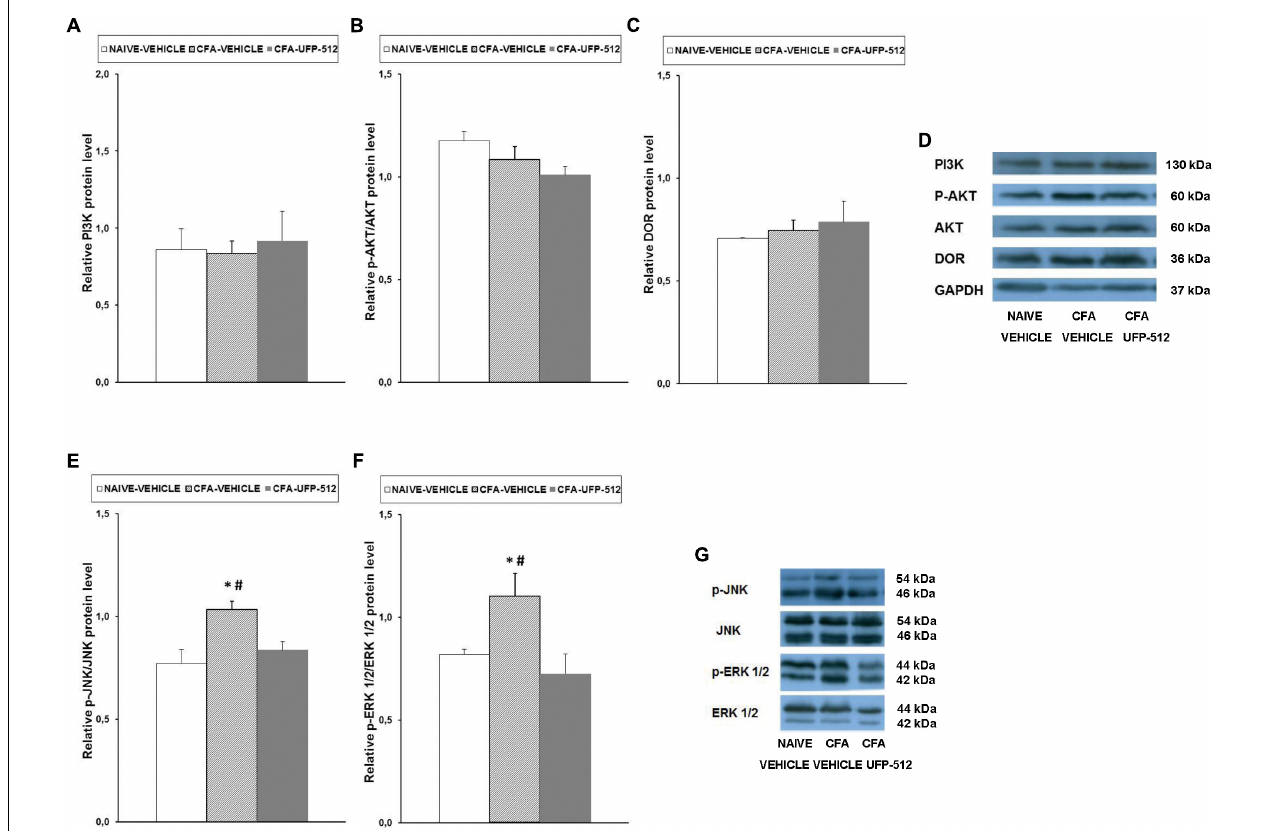
FIGURE 6 | Effects of UFP-512 on the expression of PI3K, p-Akt, DOR, p-JNK, and p-ERK 1/2 in the spinal cords of animals with peripheral inflammation. Protein levels of PI3K (A) , p-Akt (B) , DOR (C) , p-JNK (E) , and p-ERK 1/2 (F) in the ipsilateral site of spinal cords of CFA-injected mice treated with UFP-512 (CFA-UFP-512) or vehicle (CFA-vehicle) are represented. Controls corresponding to naive mice treated with vehicle (naive-vehicle) are also shown. For each protein, ∗ indicates significant differences vs. naive-vehicle treated mice and # indicates significant differences vs. CFA-injected mice treated with UFP-512 ( P < 0.05, one-way ANOVA, followed by the Student–Newman–Keuls test). Representative examples of western blots for PI3K (130 kDa), p-Akt (60 kDa), Akt (60 kDa), DOR (36 kDa), and GAPDH (37 kDa) are shown in (D) and for p-JNK/total JNK protein (46–54 kDa) and p-ERK 1/2/total ERK 1/2 (42–44 kDa) in (G) . Phosphorylated proteins are expressed relative to their corresponding total proteins while the rest are relative to GAPDH. Results are expressed as mean ± SEM; n = 4 samples per